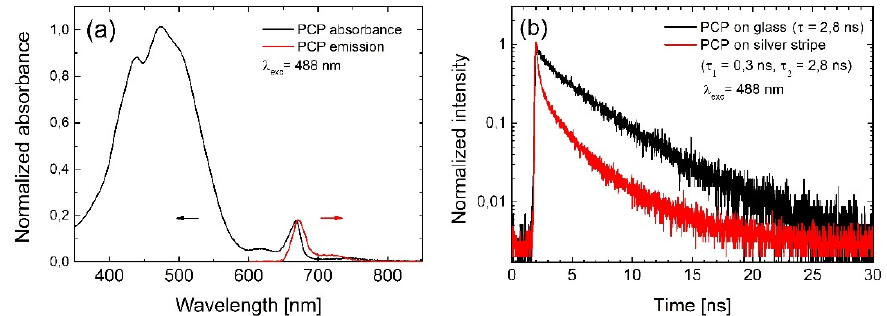
Figure 1. ( a ) Absorption and emission spectra of peridinin-chlorophyll-protein (PCP) complexes. ( b ) Photoluminescence decay transients acquired for PCPs deposited on glass (black line) and silver stripes (red line).